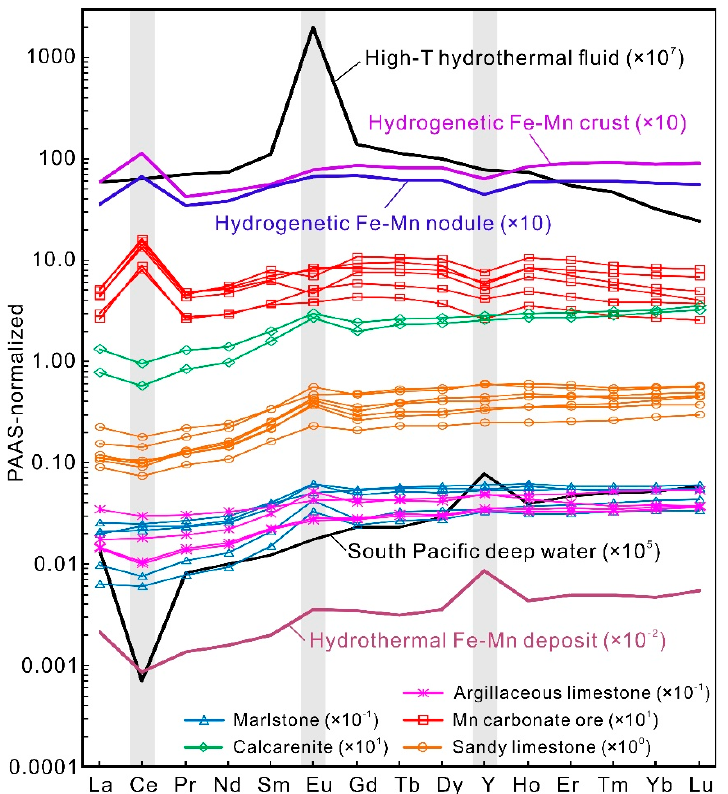
Figure 4. Post-Archean Average Shale (PAAS)-normalized REE+Y distributions of the Ortokarnash Mn(II) carbonate ores and associated wall rocks. Note that, for comparison, those of different origins of marine ferromanganese deposits [76,77], high-temperature (T) hydrothermal fluid [78], and South Pacific deep water [79] are also plotted whole rocks. PAAS data from [80].